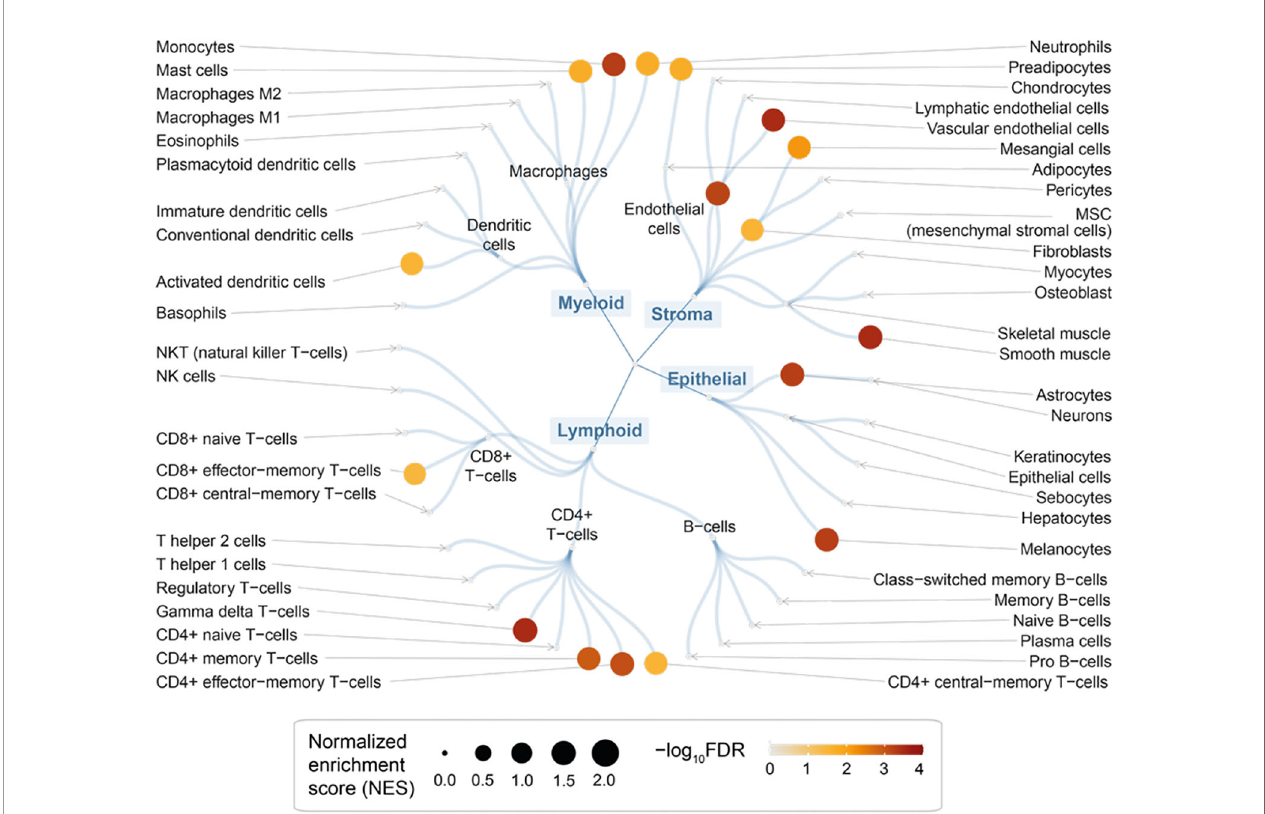
FIGURE 4 | Cellular basis of therapeutic targeting in endometriosis. Circular overview of cell type enrichments, with nodes sized by the normalized enrichment score (NES) and colored by the enrichment signi fi cance (FDR) calculated using target set enrichment